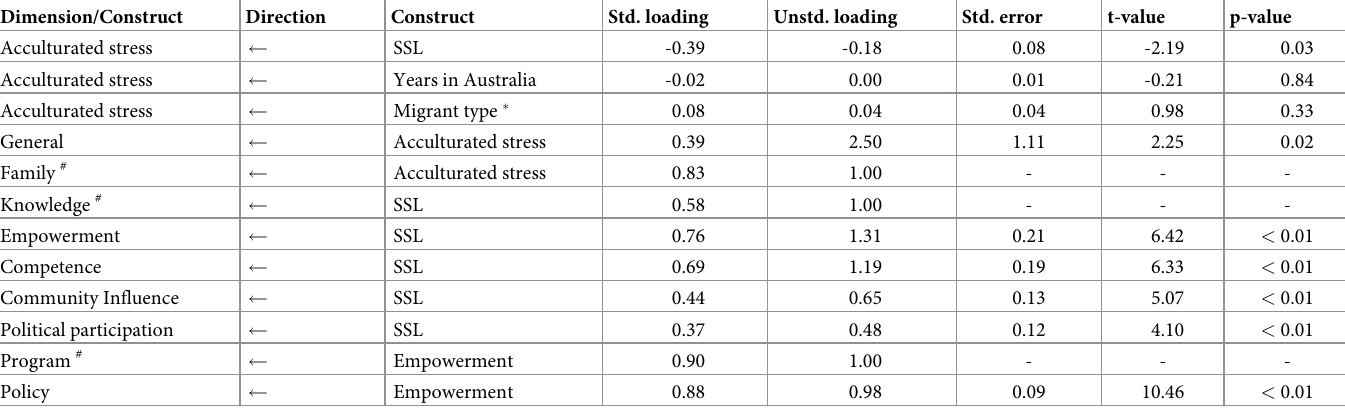
Table 6. Results of the nomological validity